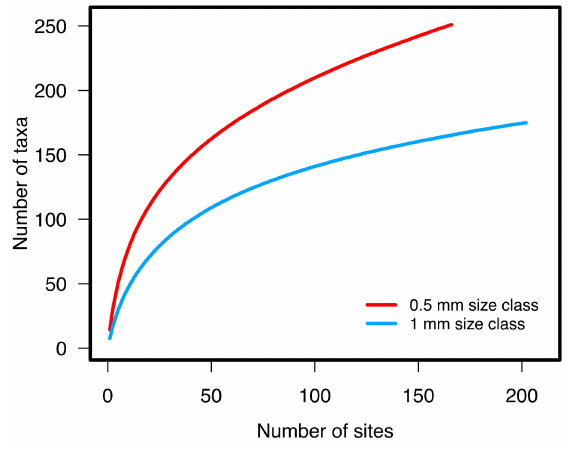
Figure 2. Rarefaction curves for taxa assemblages of the 0.5 mm and the 1 mm size classes. Table 1. Mean values (and standard error) of community characteristics calculated with stations included in the 0.5 mm and the 1 mm size